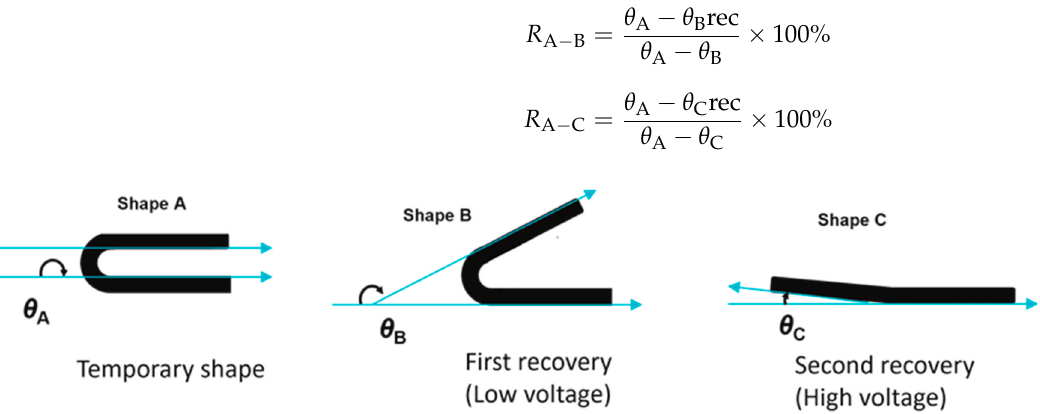
Figure 2. A schematic demonstration of the triple-shape bending procedure.